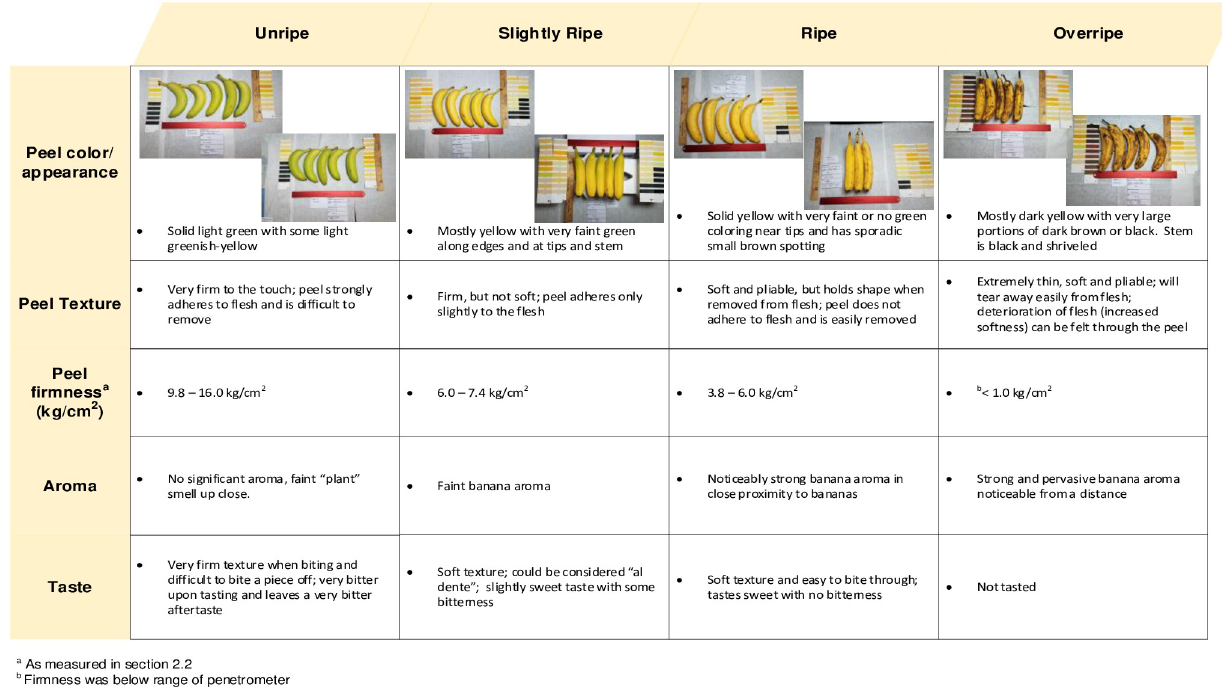
Fig 1. Criteria for assessed ripeness of